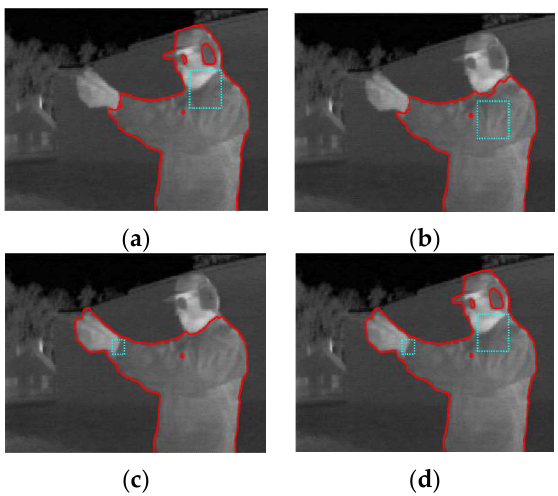
Figure 12. Segmentation results with different initial contours (cyan lines stand for the initial curves). ( a ) Segmentation result with initial contour around the neck. ( b ) Segmentation result with initial contour around the shoulder. ( c ) Segmentation result with initial contour around the wrist. ( d ) Segmentation result with initial contour around the shoulder and wrist.